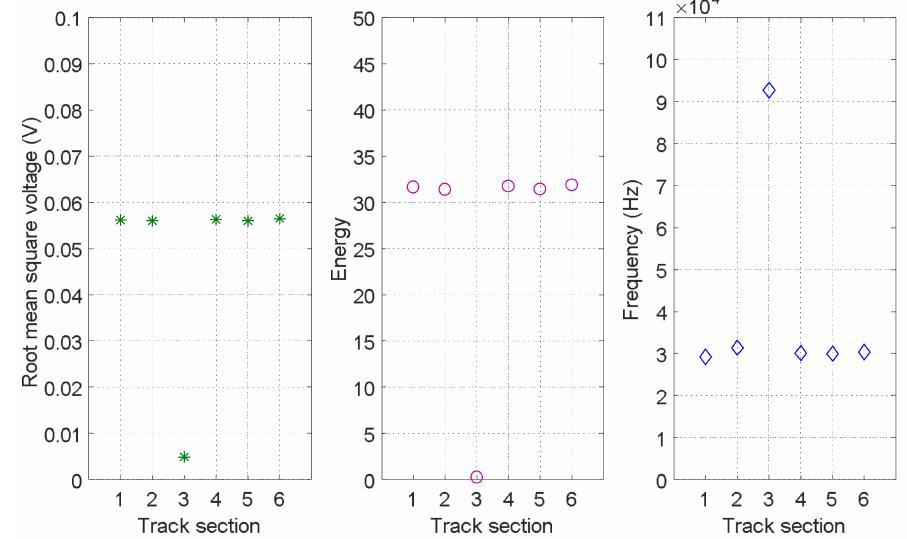
Figure 22. Spatial dependencies of features [ V RMSi E i f Pi ] for six neighbouring track sections S i , i = 1, 2, . . . , 6 in rail no. 2 when section S 3 is